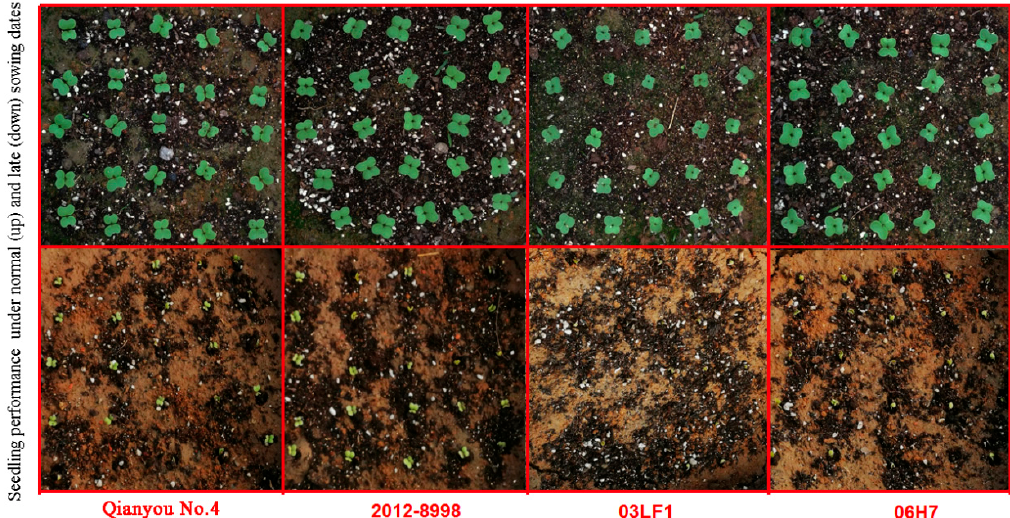
Figure 6. Seedling emergence performance of rapeseed genotypes with high or low comprehensive low ‐ temperature tolerance index under normal ‐ temperature (normal sowing date) and low ‐ temperature (late sowing date) conditions after 4 days of sowing in the pot experiment.